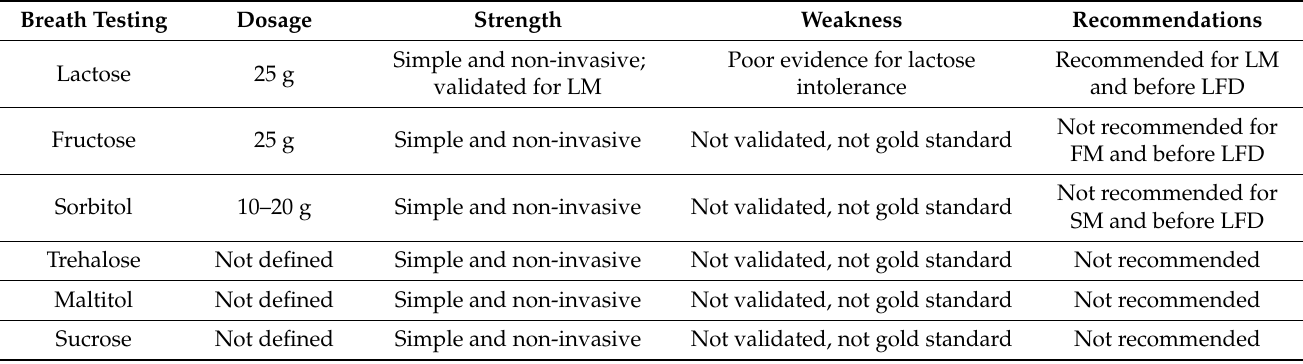
Table 2. Breath tests for sugar malabsorption: diagnostic strengths and